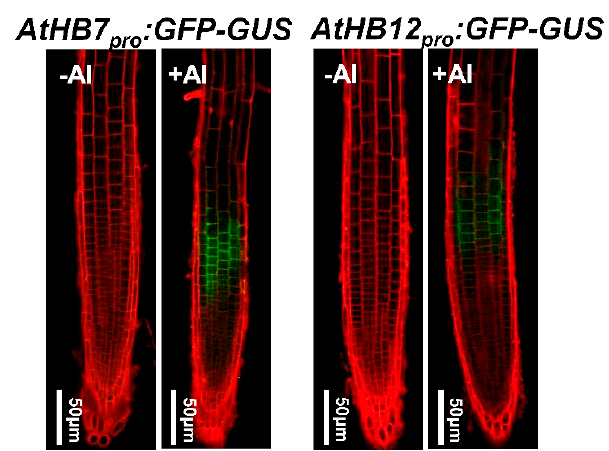
Figure 2. Both AtHB7 and AtHB12 were induced by Al toxicity in transition zone. Expression of AtHB7pro:GFP-GUS and AtHB12pro:GFP-GUS in root tips of seedlings exposed without or with 20 μ M Al for 6 h were analyzed by observation using confocal laser scanning